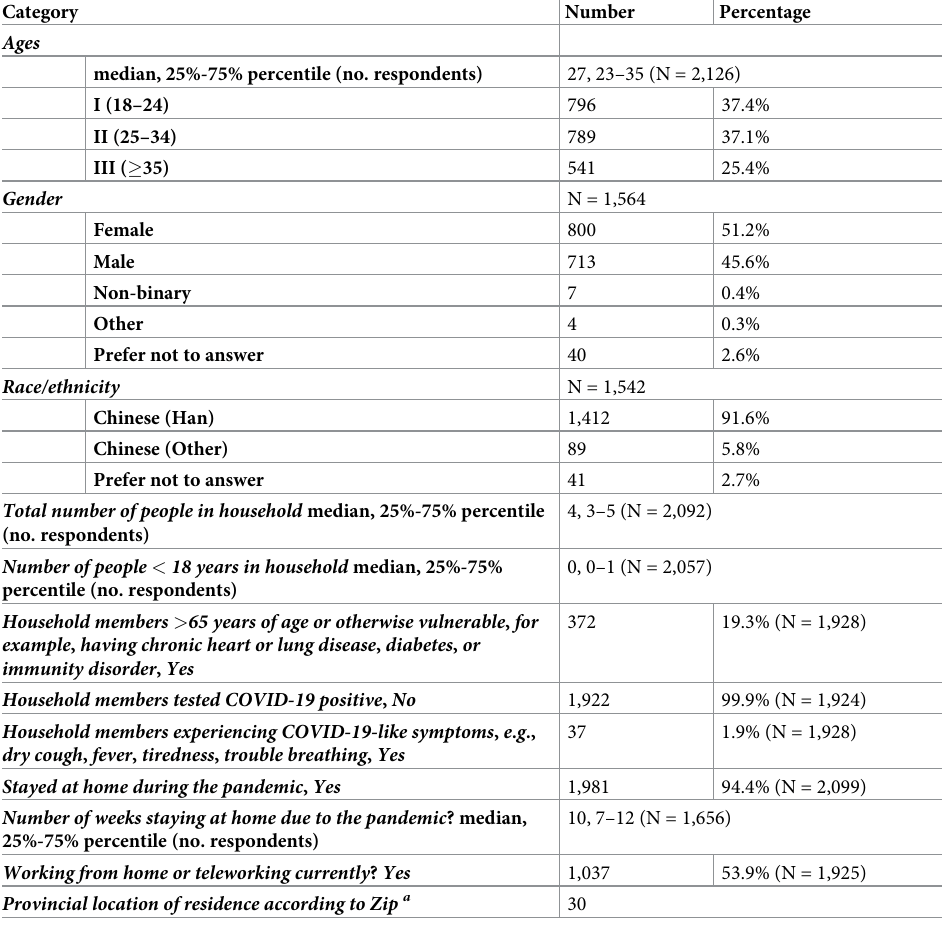
Table 1. Demographic information of survey